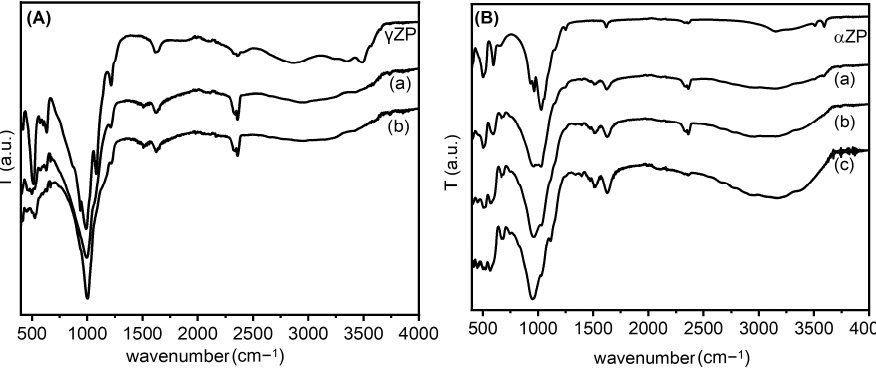
Figure 3. Frame ( A ): FT-IR spectra of γ ZP, γ ZP05 (a); γ ZP1 (b). Frame ( B ): FT-IR spectra of α ZP, α ZP05 (a), α ZP1 (b), and (c) α ZP2.